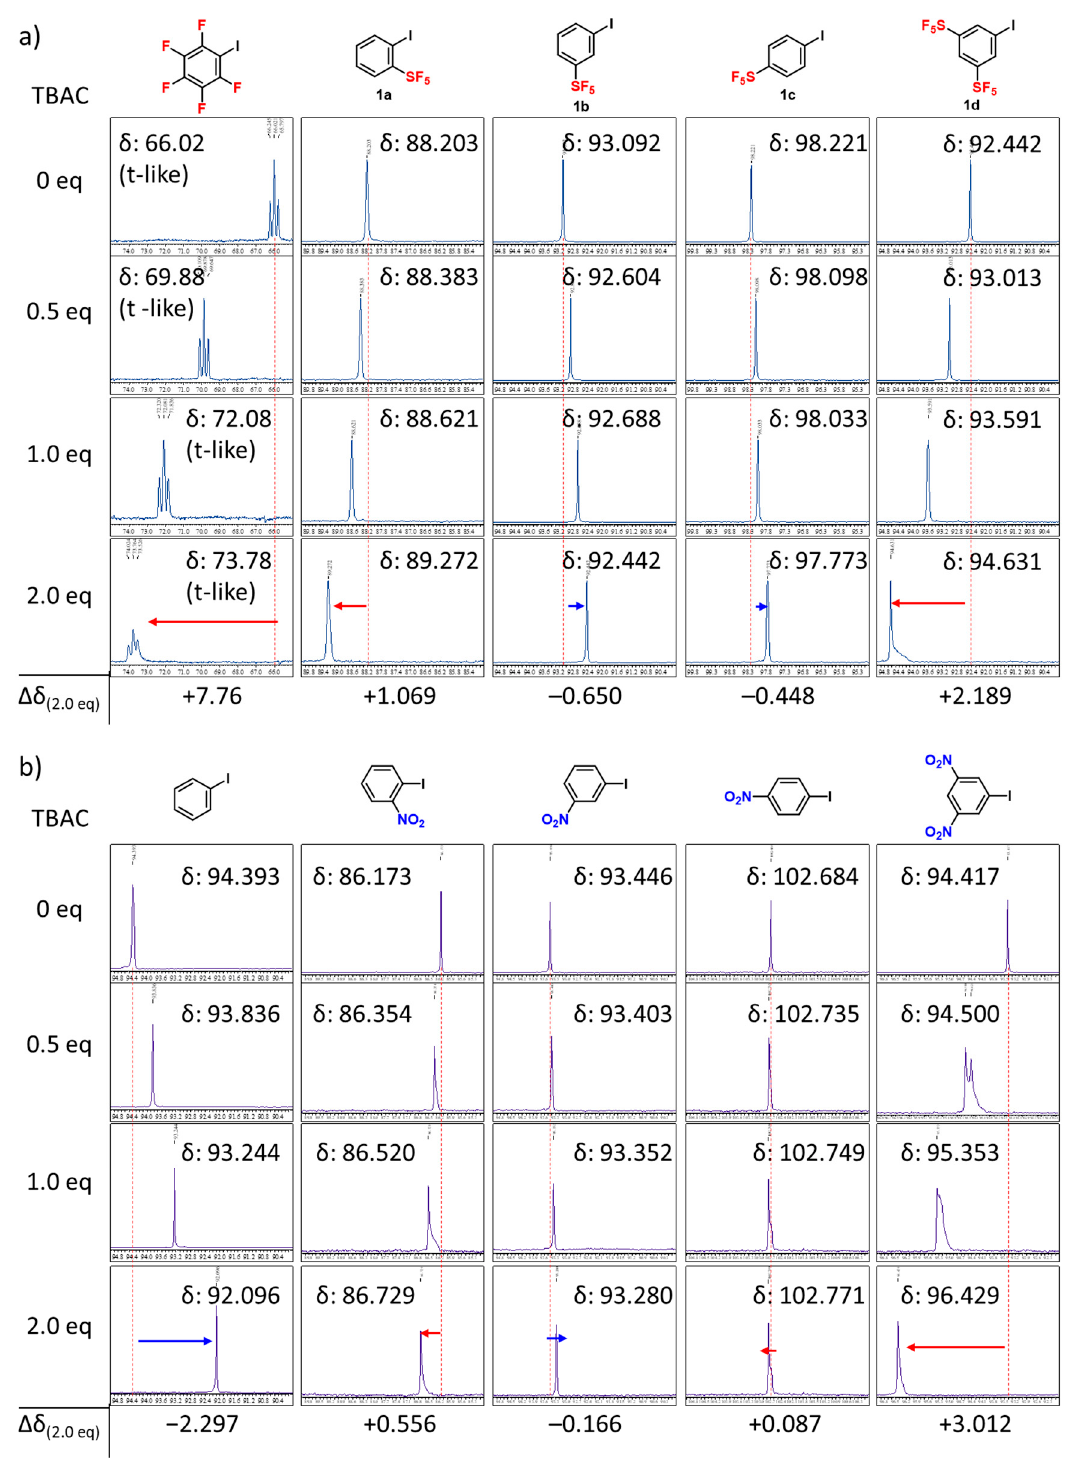
Figure 5. Change in the 13 C-NMR chemical shift of the carbon atom bonded to iodine in Ar − I with equivalents of tetra ( n -butyl) ammonium chloride (TBAC) in CDCl 3 . ( a ) pentafluoro-iodobenzene; o -SF 5 -iodobenzene ( 1a ); m -SF 5 -iodobenzene ( 1b ); p -SF 5 -iodobenzene ( 1c ); 3,5-bis-SF 5 -iodobenzene ( 1d ). ( b ) iodobenzene; o -NO 2 -iodobenzene; m -NO 2 -iodobenzene; p -NO 2 -iodobenzene; 3,5-bis-NO 2 -iodobenzene.